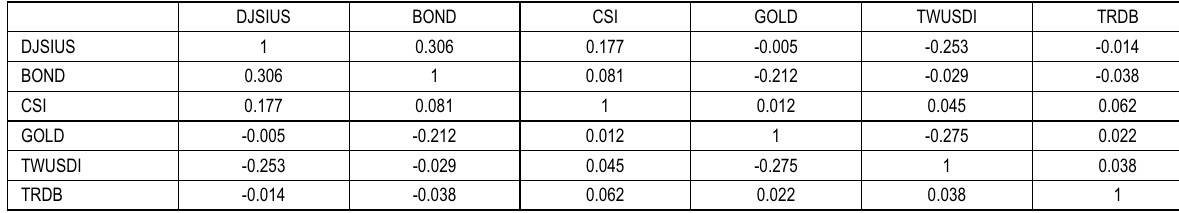
Table 3. Correlation matrix